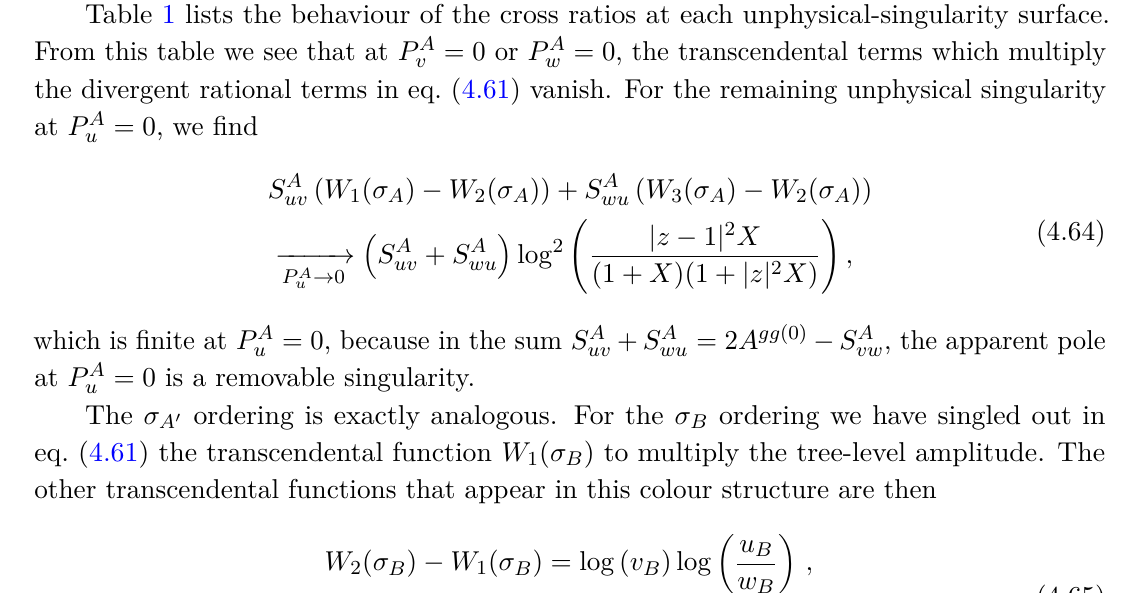
Table 1 . Behaviour of the cross ratios in the NMRK limit at the three unphysical-singularity surfaces of the rational terms of the ordering σ , listed in eq. (3.21). A Table 1 lists the behaviour of the cross ratios at each unphysical-singularity